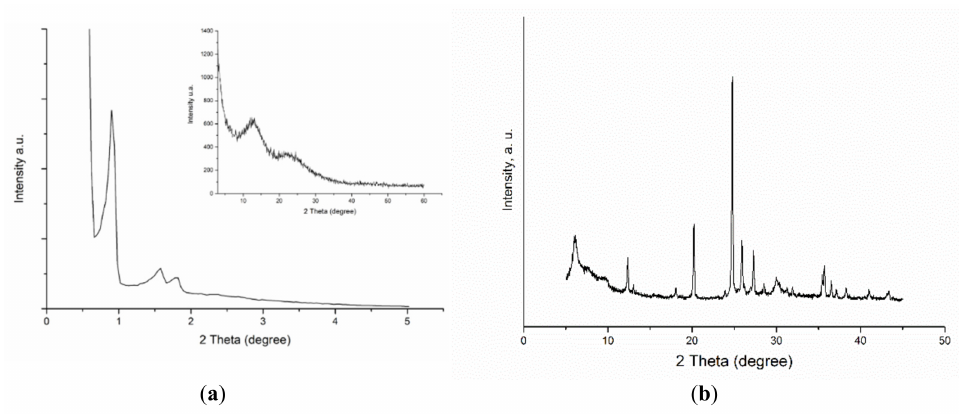
Figure 1. Low-angle XRD pattern of silica SBA-15 ( a ) and XRD) pattern of titanosilicate ETS-10 ( b ).